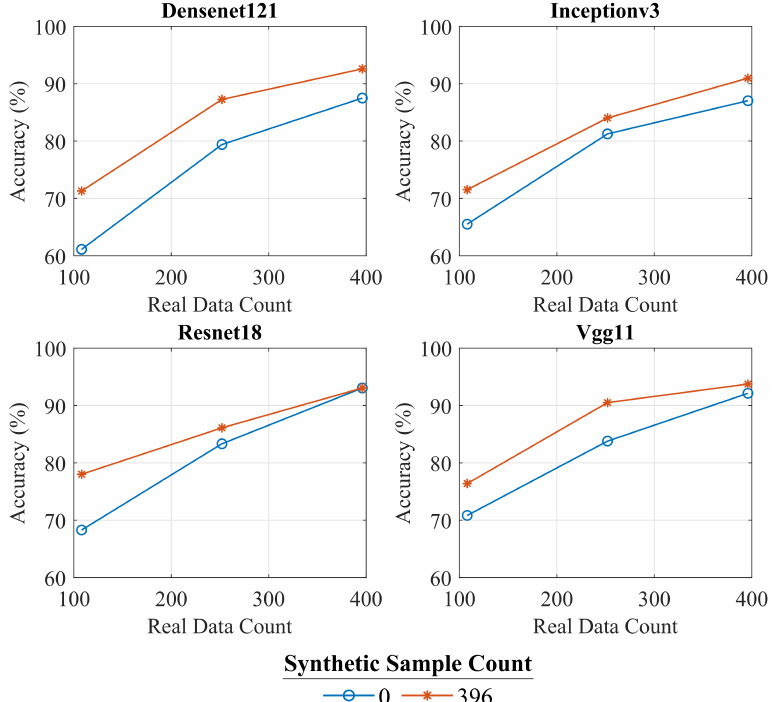
Figure 7. Accuracy of each network when altering the count of real data within the training process. Two counts of synthetic data are shown. These results correspond to the configuration pairings C1/C4, C5/C6, and C7/C8.